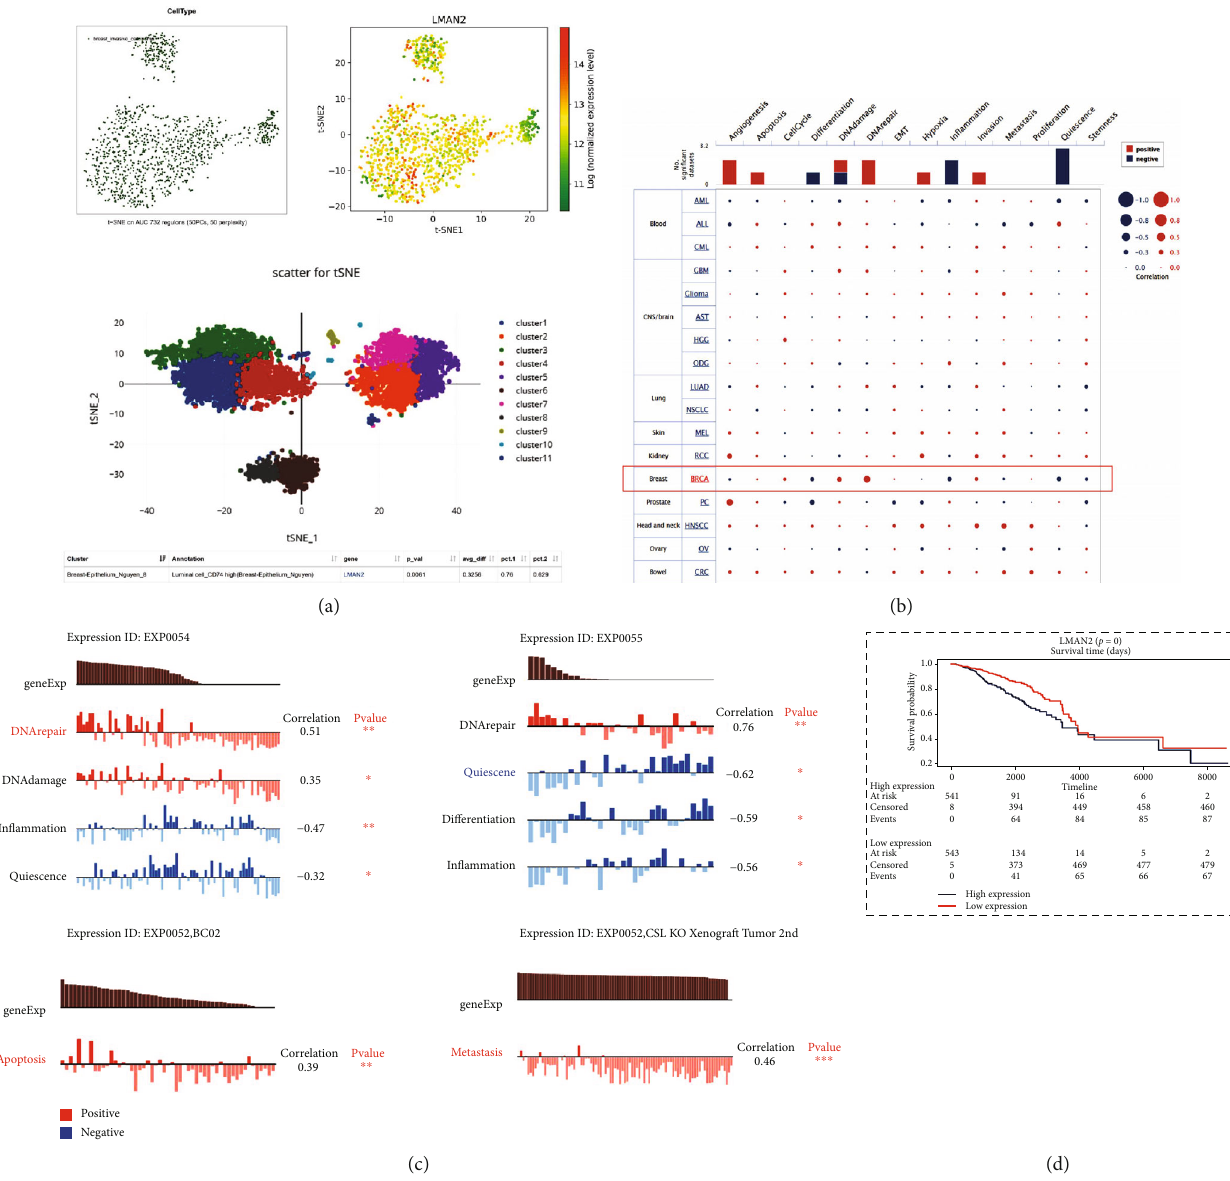
Figure 4: The expression of LMAN2 is, in distinct cellular populations, positively correlated with apoptosis, metastasis, and DNA repair of breast cancer cells. (a) The characteristics of the LMAN2 map and marker genes in breast cancer samples were determined using a human cell landscape. LMAN2 expression in breast-epithelium-Nguyen-8 datasets was statistically signi fi cant. A p value < 0.05 represents a signi fi cant di ff erence. (b) The signi fi cance of LMAN2 in 14 functional states of di ff erent malignancies, as determined by CancerSEA. (c) Correlation analysis between the LMAN2 expression of functional status in distinct single-cell datasets and functional signi fi cance in diverse cell groups using CancerSEA. The correlation of LMAN2 functional status in EXP0052, EXP0054, and EXP0055 single-cell datasets was statistically signi fi cant. (d) Single-cell analysis of LMAN2 has a meaningful prognosis (GRNdb) ( ∗∗∗ p ≤ 0 : 001 ; ∗∗ p ≤ 0 : 01 ; ∗ p ≤ 0 : 05